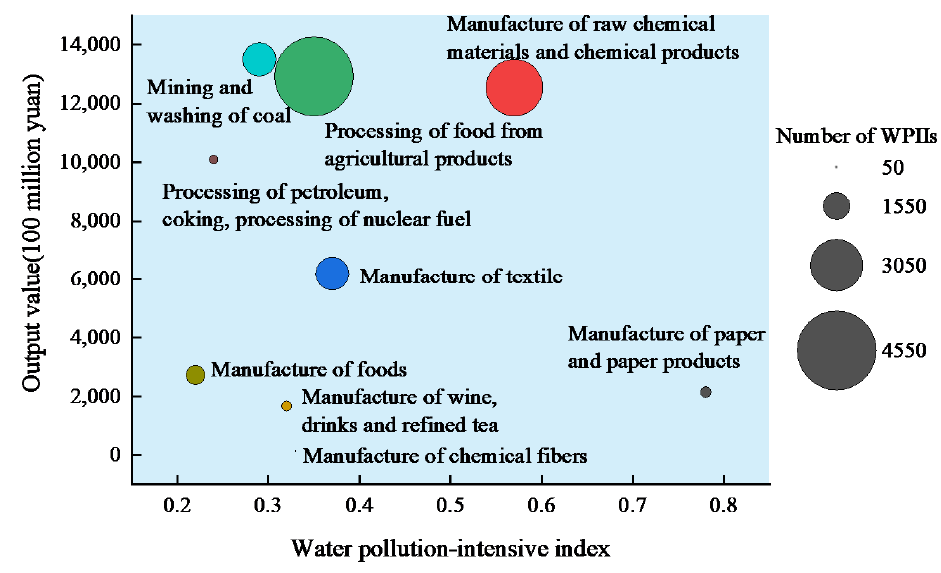
Figure 3. Output value and water pollution-intensive index of WPIIs by industry in 2013.